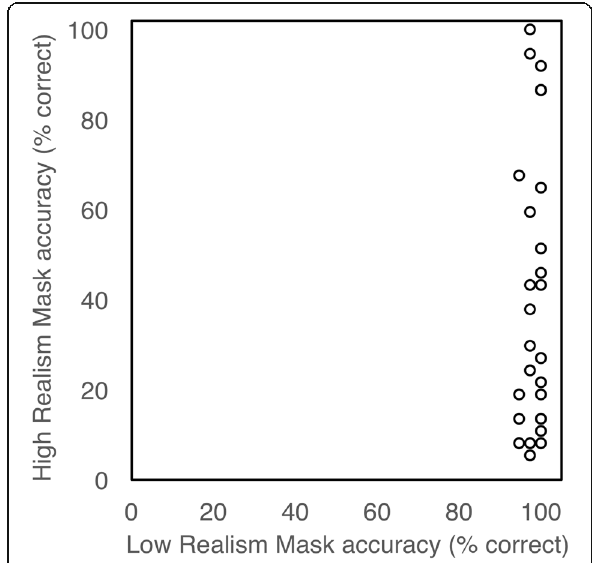
Fig. 4 Scatterplot showing participants ’ mean categorization accuracy rates in the high-realism and low-realism mask conditions in Study 1